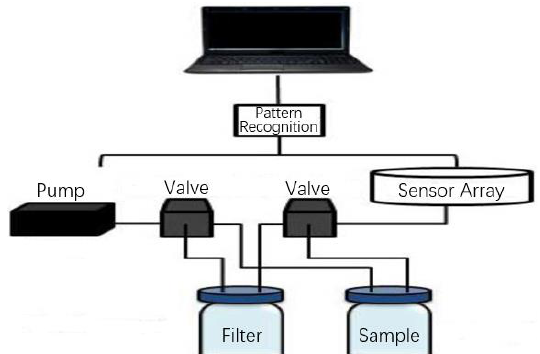
Figure 4. Schematic diagram of the QCM-based e-nose.